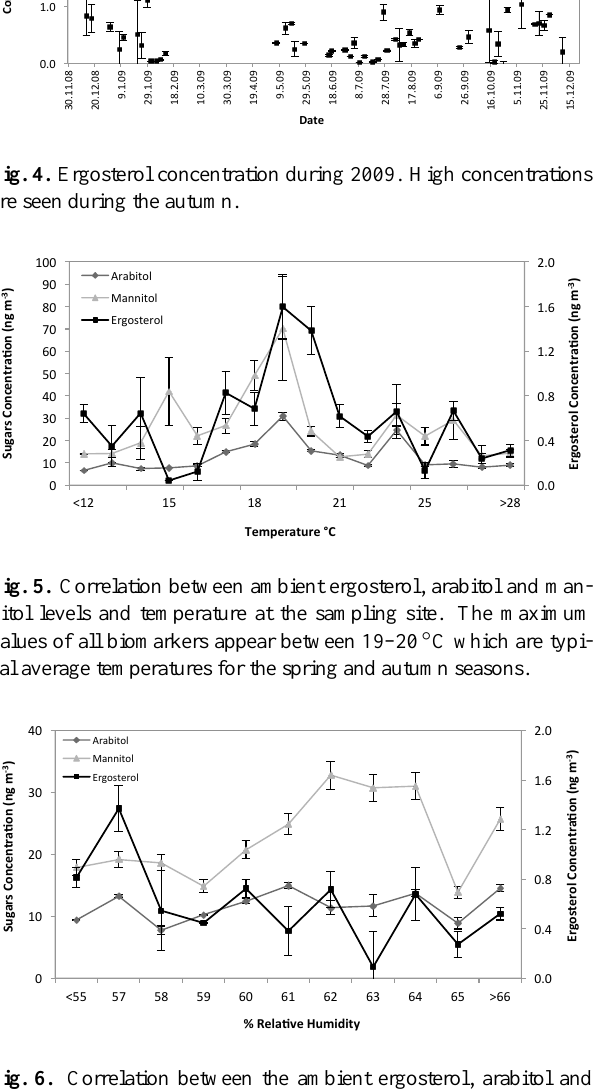
relative humidity was not reported. Arabitol and mannitol show high levels between 18–21 ◦ C, as ergosterol does. Rel- ative humidity levels did not show significant influence on arabitol, while mannitol levels are the highest when the RH is between 62–64%. The different influence of the relative humidity on the biomarkers can be another indication for the different sources of each of